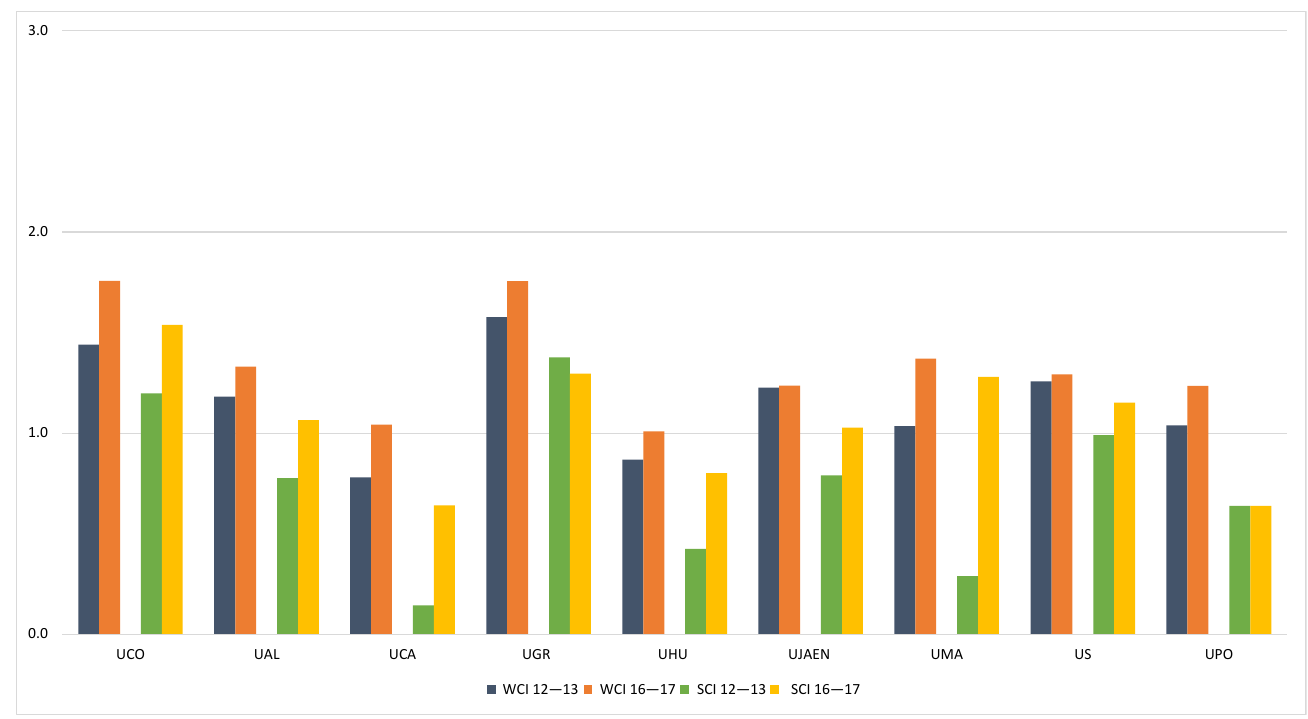
Figure 6. Evolution in the research mission of the Andalusian public university system from 2012–2013 to